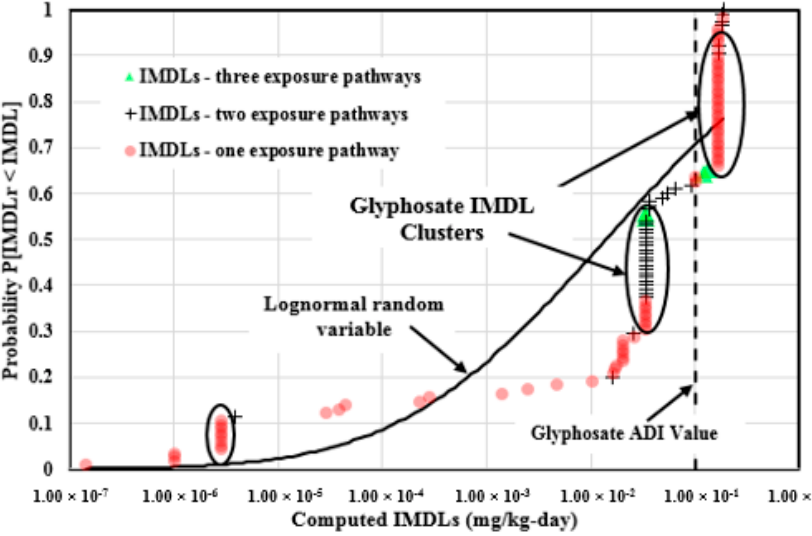
Figure 9. Glyphosate IMDLs computed from soil, drinking water, and the commonly consumed agricultural commodities plotted in the empirical cumulative distribution form and compared to the log-normal random variable cumulative distribution with identical statistics.